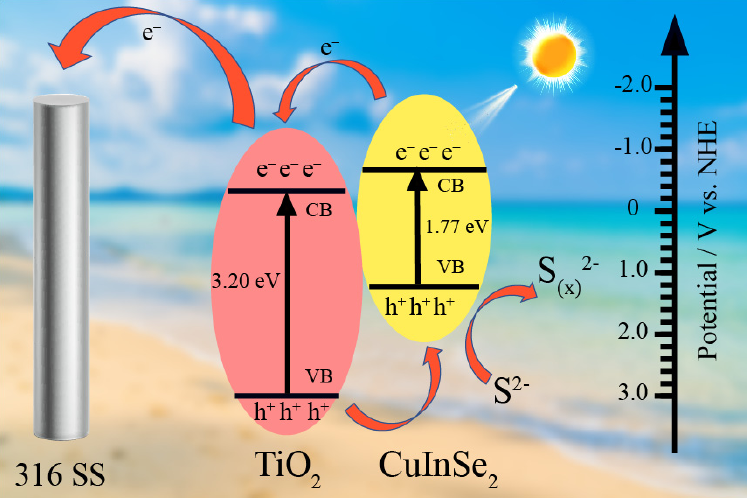
Figure 10. The calculated TDOS and PDOS for ( a ) TiO 2 , ( b ) CuInSe 2 and ( c ) CuInSe 2 /TiO 2 . The possible mechanism for the improved protection of CuInSe 2 /TiO 2 photoanodes